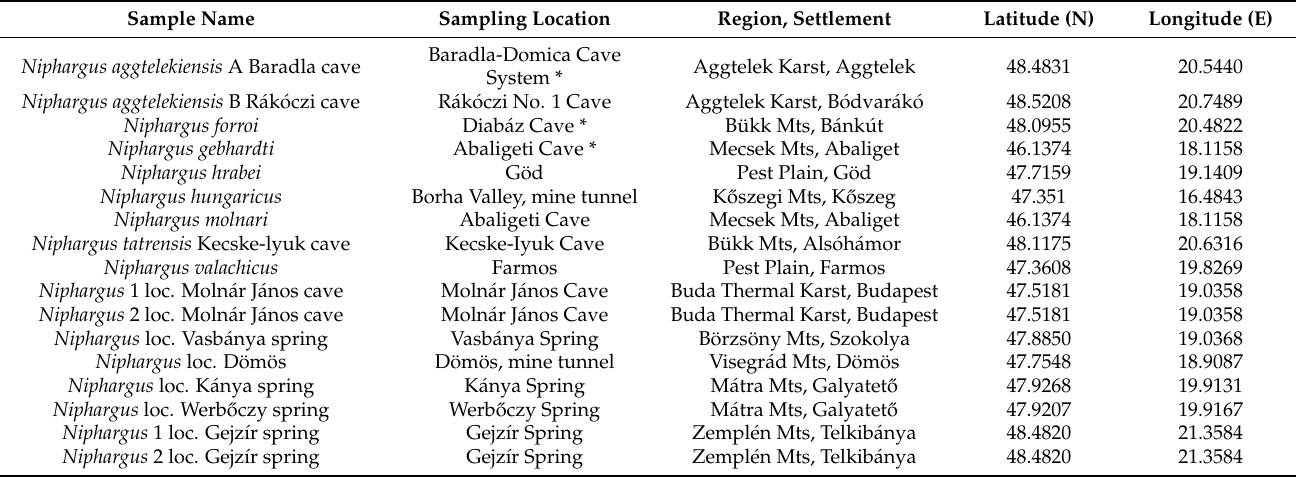
Table 1. Sampling locations of Hungarian taxa of Niphargus